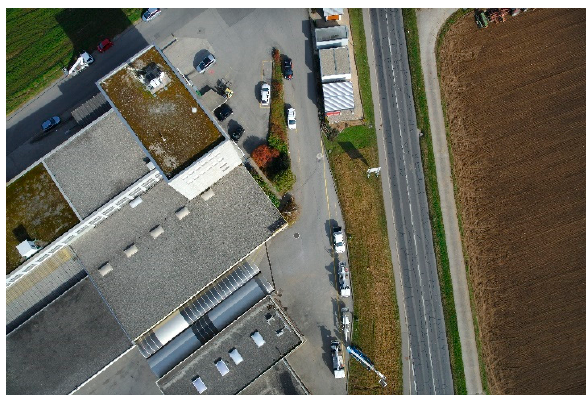
Figure 2. Sample image of SenseFly Drone Dataset.